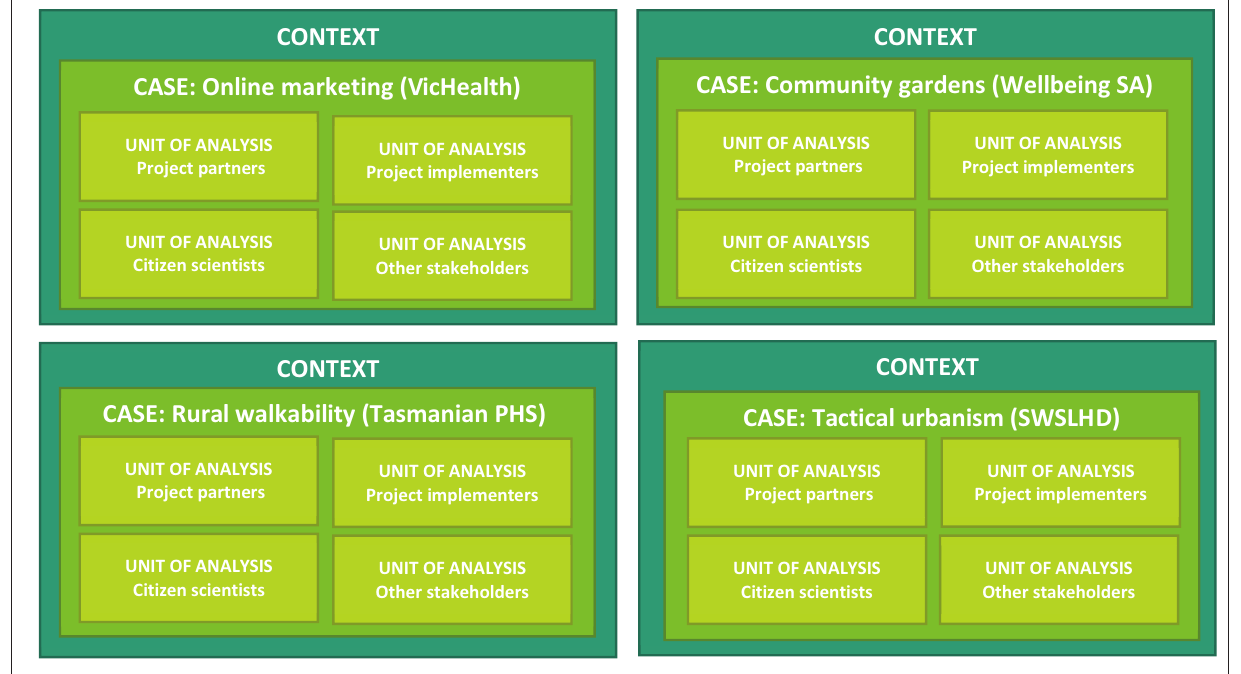
Figure 3 Overview of embedded multiple–case study design (adapted from Yin 2009).